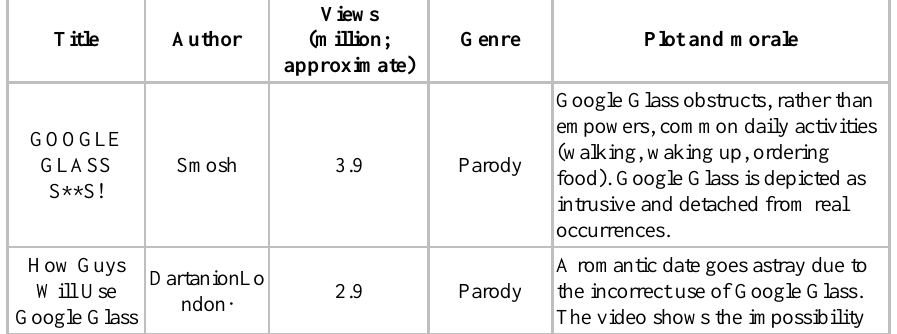
Table 1. Google Glass videos: the most popular user-generated